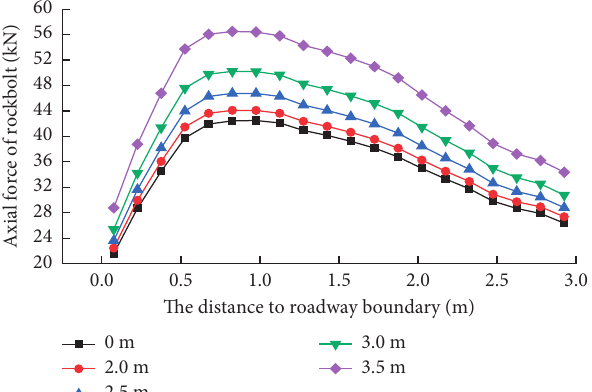
Figure 15: Axial force of rockbolt with different water injection fracturing